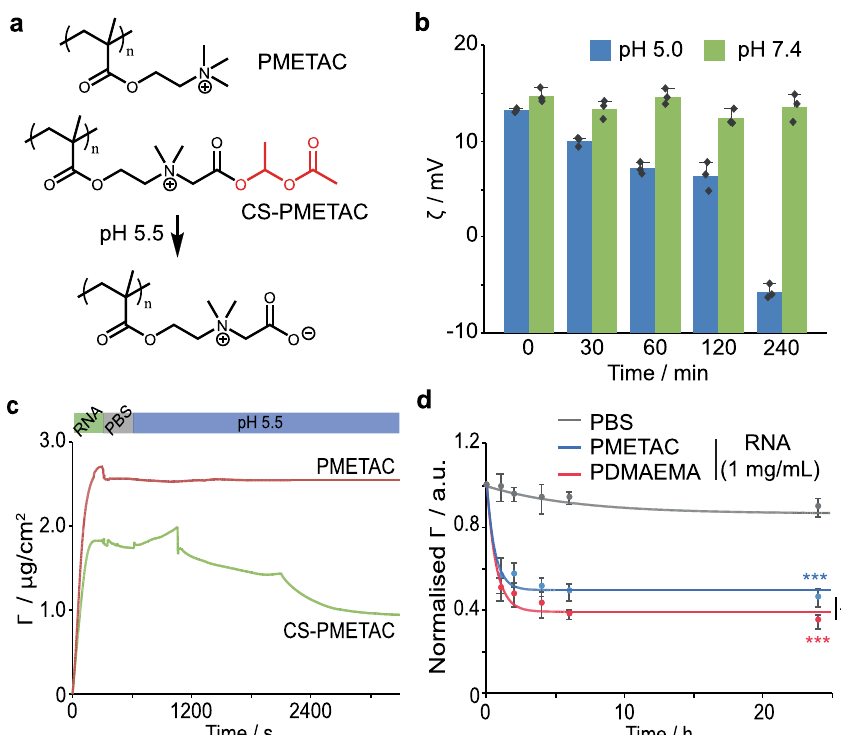
Fig. 4 Design of engineered polymer brush vectors regulating competitive binding. a Structure of PMETAC and CS-PMETAC brushes. b Change in ζ - potential of silica nanoparticles coated with CS-PMETAC upon incubation in pH 5.0 and pH 7.4 PBS for different time points, up to 4 h. c Quanti fi cation of siRNA adsorption (10 μ g/mL; 50 μ L injected at 10 μ L/min fl ow rate) on PMETAC and CS-PMETAC brushes, measured by SPR, followed by washing in PBS at neutral pH and pH 5.5. d Release pro fi le of cy5 tagged siRNA from PDMAEMA and PMETAC brush-grafted microparticles in the presence of competing RNA (1 mg/mL in PBS). a.u., arbitrary units. Data are presented as mean values. Error bars are standard errors from triplicate experiments. n.s., not signi fi cant; * p < 0.05; *** p < 0.001 (ANOVA); with respect to PBS ( d ), unless indicated